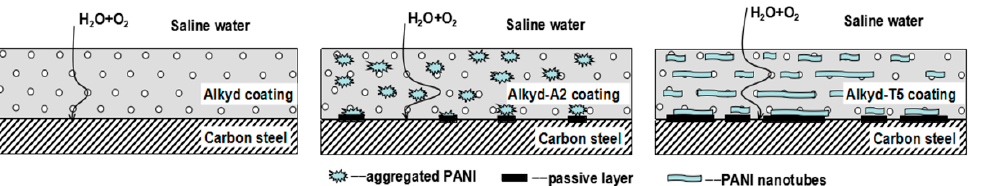
Figure 8. Mechanism of corrosion protection of alkyd containing PANI nanostructures. Table 1. Tafel curves parameters for uncoated CS, CS-A-PANI, and CS-N-PANI in 3.5 wt% NaCl solution.